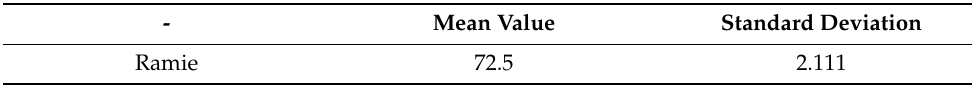
Table 7. Normal distribution parameters of annual ramie.